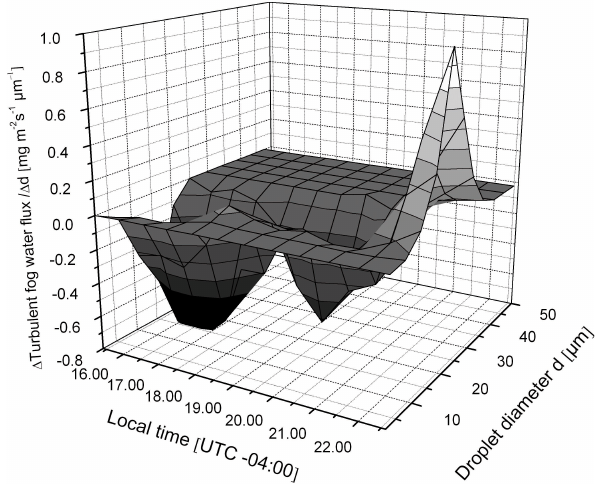
Fig. 3. Turbulent fog water flux adjusted to the different size ranges of the spectrometer ( 1 Turbulent fog water flux/ 1 d) over droplet diameter and time for 18 August 2008. 30-min intervals are shown as obtained with the eddy covariance